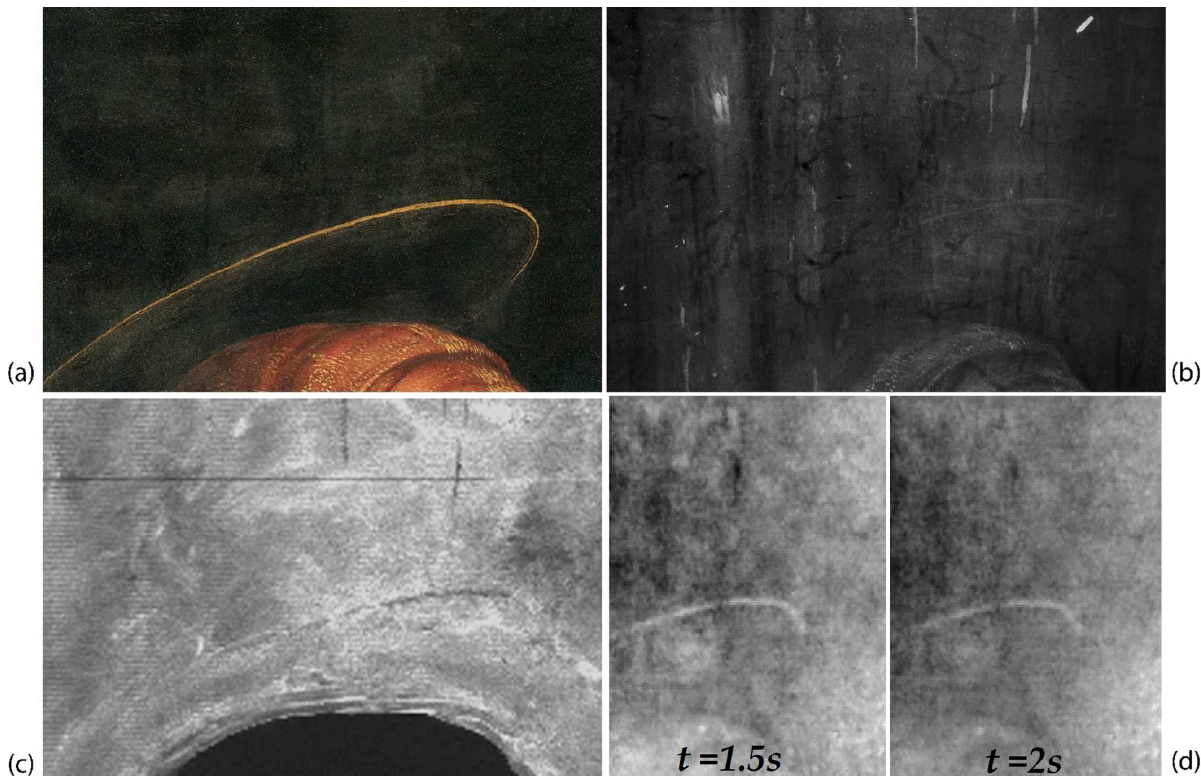
Figure 8. Vis, detail of the green curtain painted with a copper-based green pigment ( a ); XR showing the woodworm tunnels and the more radio-opaque vertical lines ( b ); MA-XRF distribution map of copper showing the lower Cu-signal along the vertical lines ( c ); PuCT thermograms at 1.5 s and 2 s when the dark vertical lines became whiter ( d ).